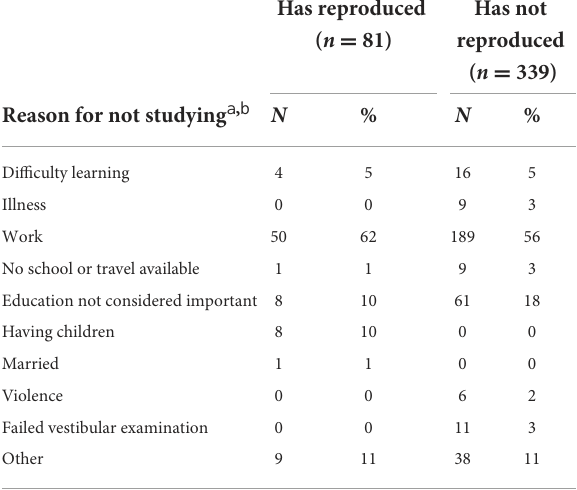
TABLE 2 Logistic regression of son reproducing by 18 years on components of maternal capital ( n = 1,922). Maternal capital